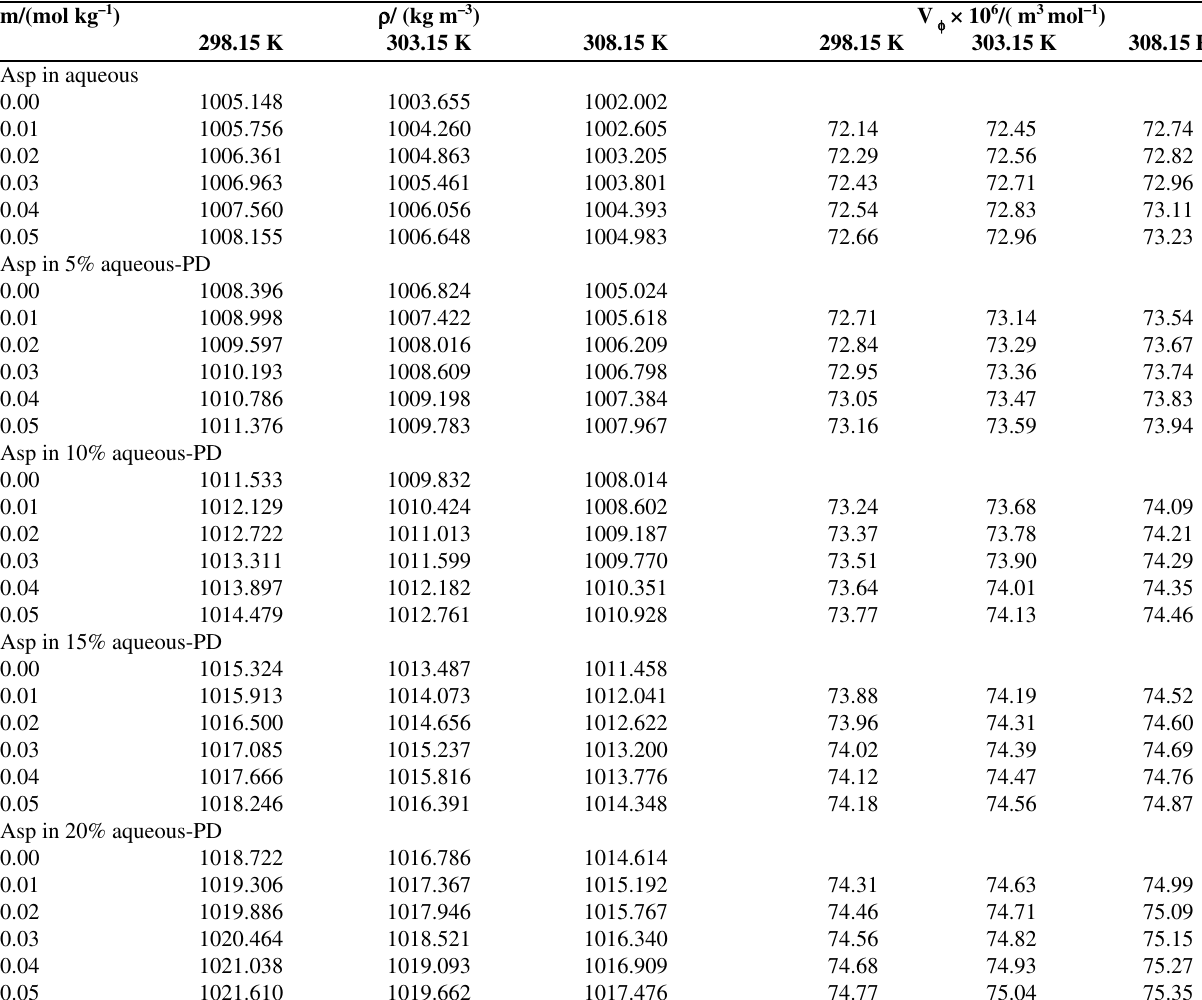
Table 1. Densities, ρ , and apparent molar volumes, V φ , of solutions of Asp in aqueous and aqueous-PD (5, 10,15 and 20%, PD w/w in water) as function of molality, m, of Asp at different temperatures. m/(mol kg –1